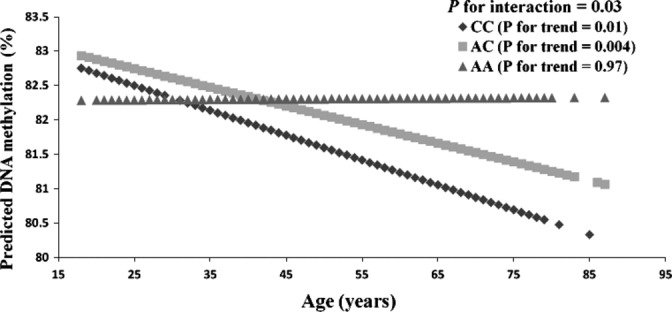
Interaction between rs405509 and age for methylation of CpG 3 (cg01032398) in GOLDN. Predicted methylation levels of cg01032398 were calculated based on the regression coefficient of the exposure variable (age) for the outcome (methylation) with the adjustment for the covariates of pedigree, sex, center, and the first principle component of cellular purity and population structure. Predicted methylation levels of cg01032398 by genotype of rs405509 were plotted against age, adjusted for pedigree, gender, center, and the first principal component of cellular purity and population structure. P-values indicate the statistical significance of the adjusted interaction term and adjusted regression coefficients in the regression line corresponding to three genotype groups of rs405509 (diamond for CC, square for AC, and triangle for AA).